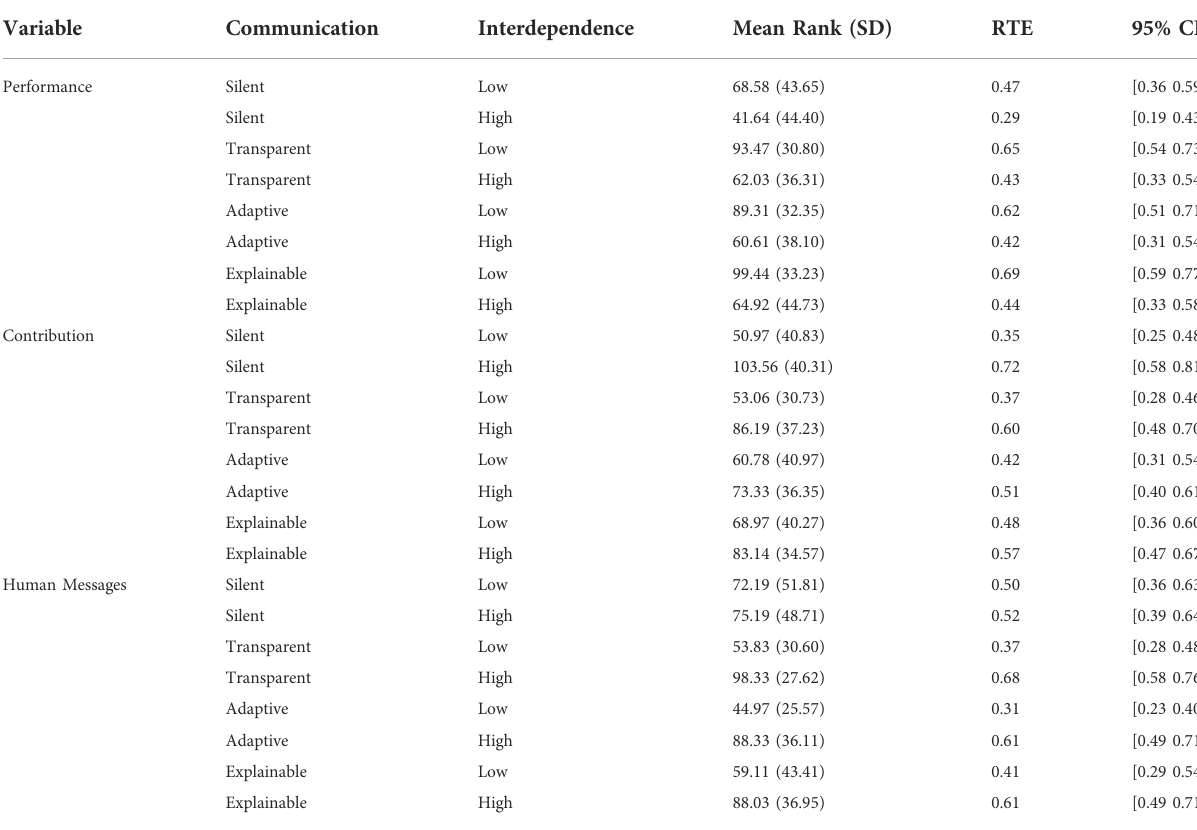
TABLE 5 Descriptive statistics for the dependent variables team performance, human rescue contribution, and number of human messages sent. Values correspond to the data points of the plots in Figures 3A – C.